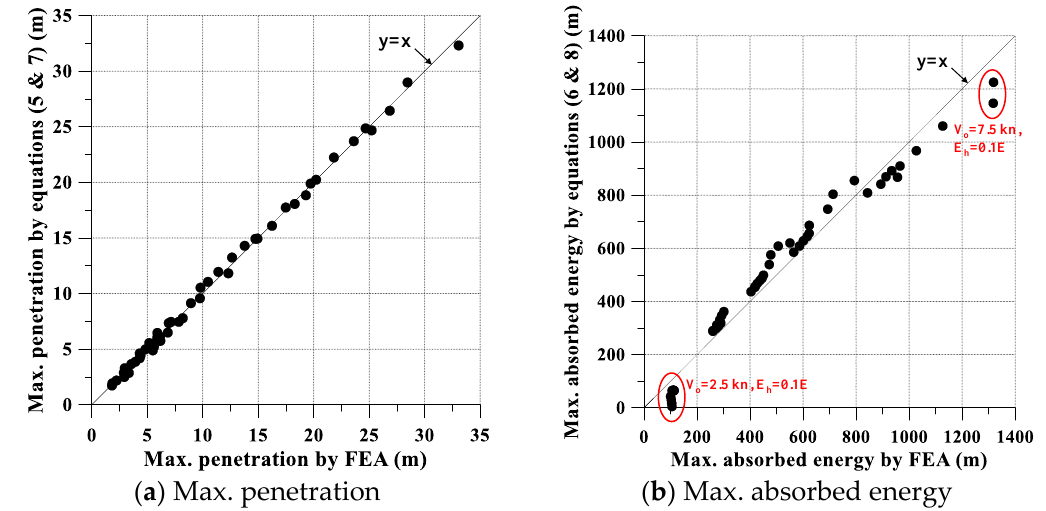
Figure 11. Comparison of structural response by FEA and developed empirical formula.